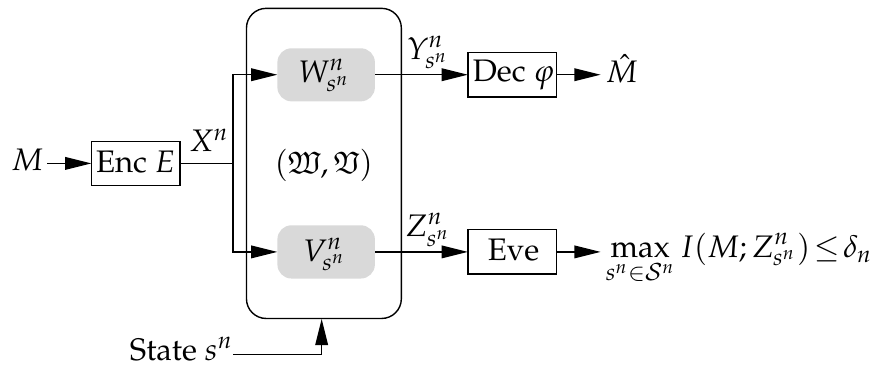
Figure 1. Arbitrarily varying wiretap channel. The transmitter encodes the message M into the codeword X n = E ( M ) and transmits it over the AVWC to the legitimate receiver, which has to decode its intended message ˆ M = ϕ ( Y n s n ) for any state sequence s n ∈ S n . At the same time, the eavesdropper must be kept ignorant of M by requiring max s n ∈S n I ( M ; Z n s n ) ≤ δ n